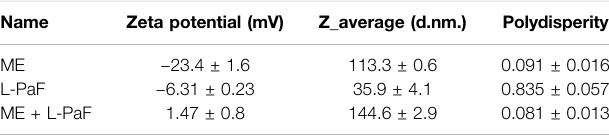
TABLE 1 | Summary table of particle characteristics of L-PaF, ME, and L-PaF + ME.